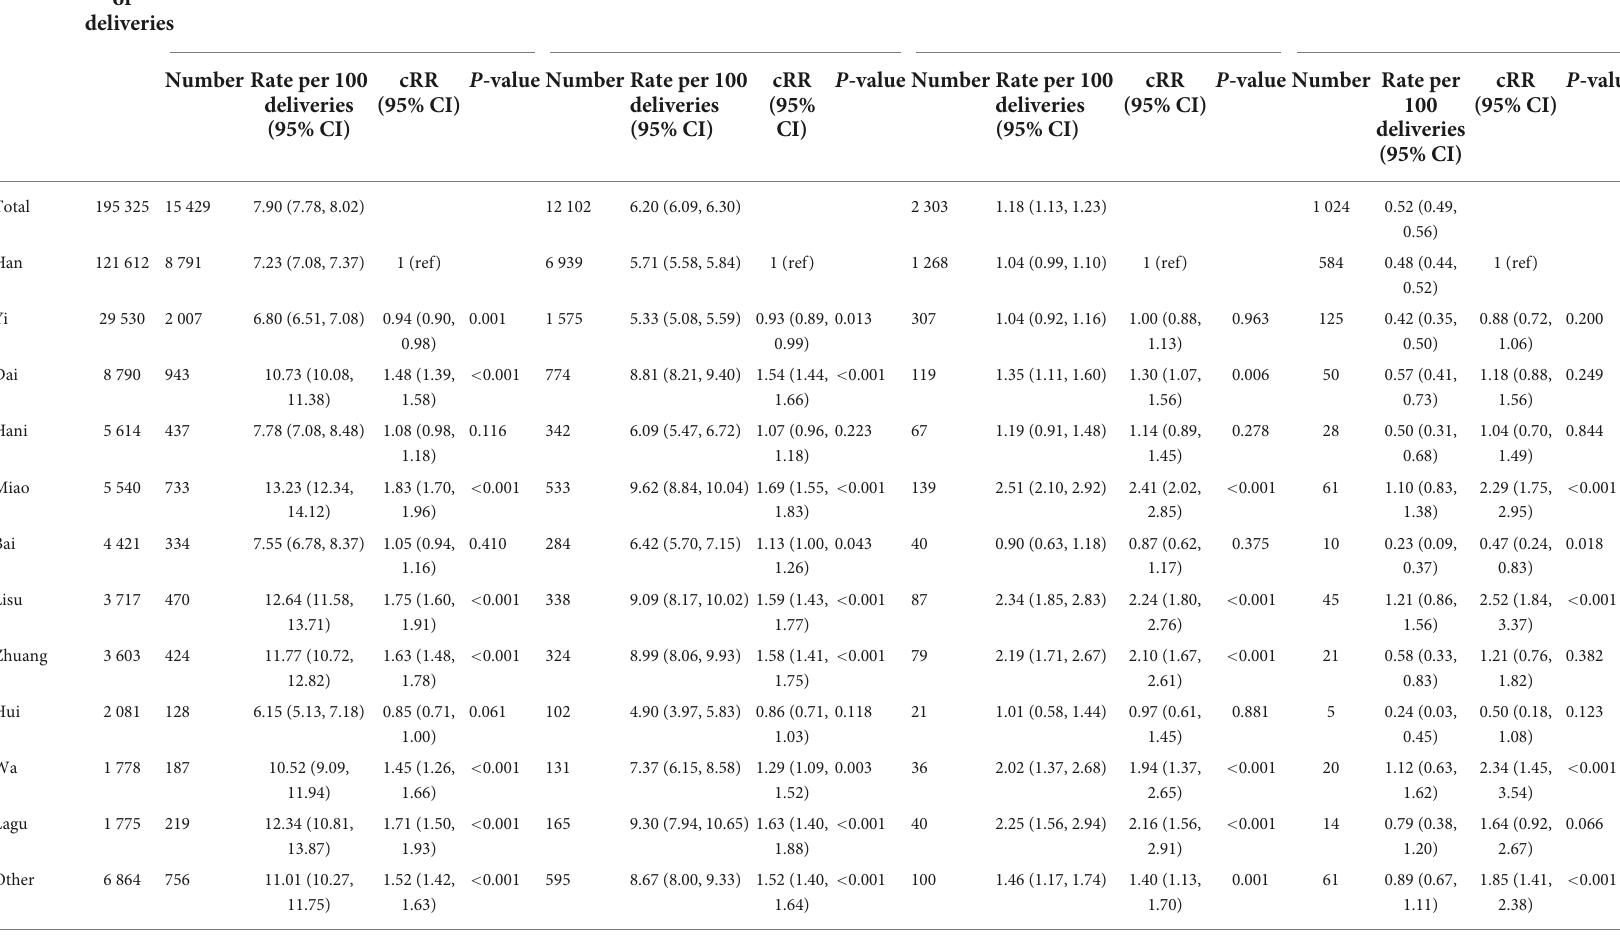
TABLE 2 Rates of preterm birth and sub-categories of preterm birth by maternal ethnicities in rural Yunnan, Southwest China, 2014–2018. Ethnicity Number